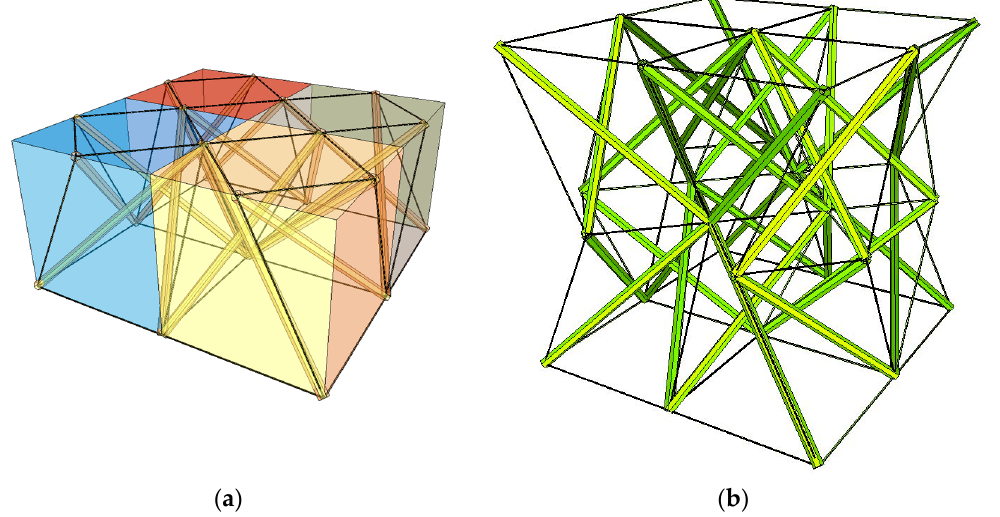
Figure 1. Geometry of a regular supercell (R): ( a ) A four-module supercell; ( b ) An eight module supercell [28].